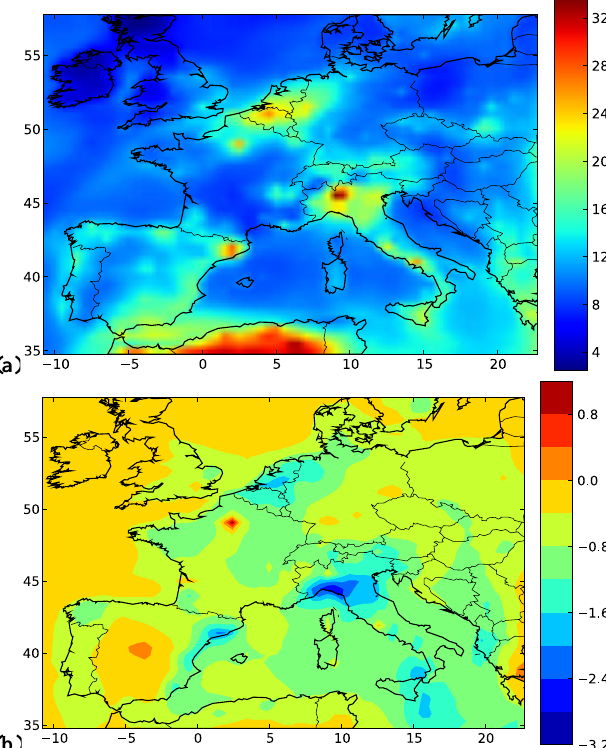
Fig. 5. Modeled PM 2 . 5 concentrations (µg/m 3 ) over Europe with (a) RACM2 and (b) the corresponding differences between the two mechanisms (CB05 –